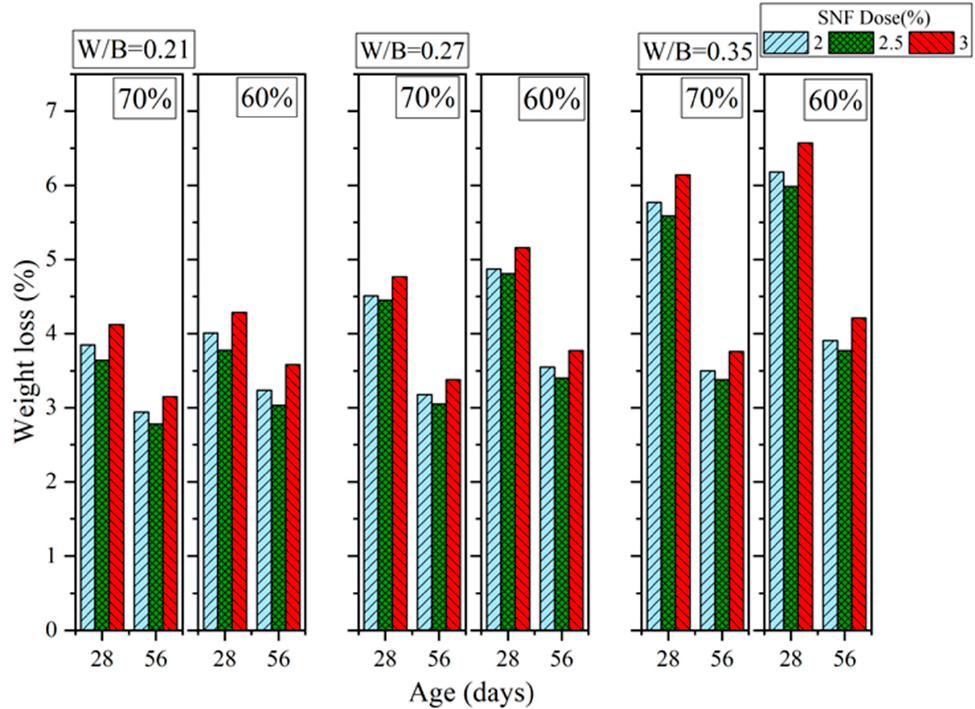
Figure 17. Sulfate resistance of green and ecofriendly grouting material with SNF.